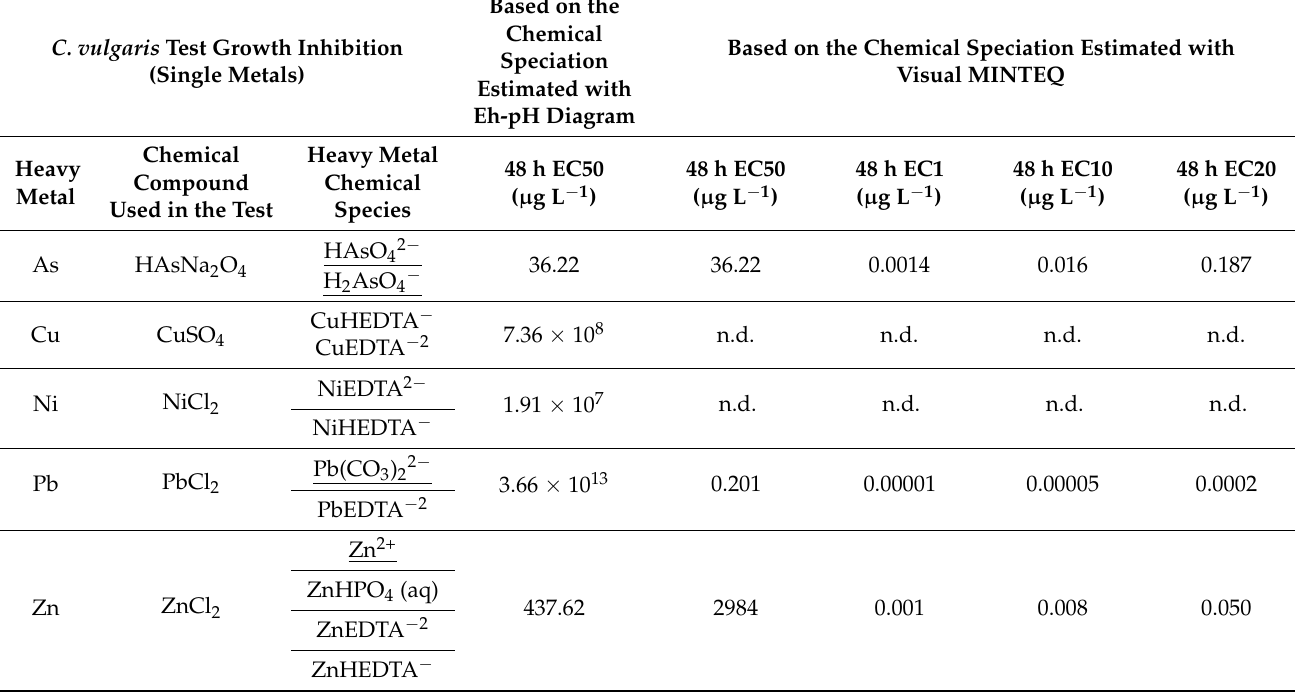
Table 2. Selected effective concentrations (ECx) for 48 h exposure to single dilutions heavy metals for growth inhibition calculated with Matlab concentration-response